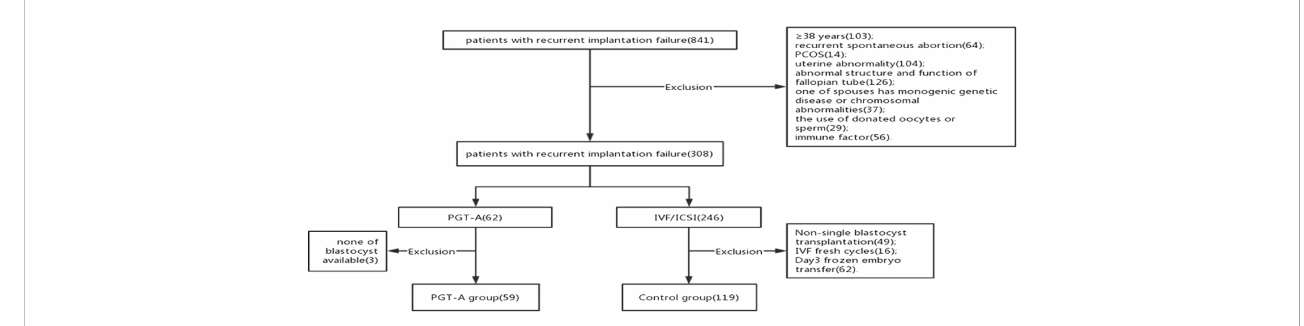
FIGURE 1 Flow chart of study